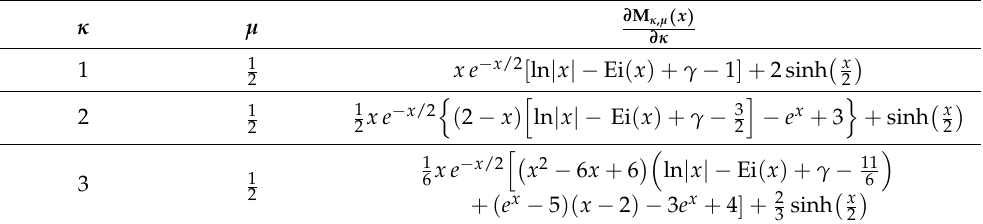
Table 2. Derivative of M κ , µ with respect to κ using